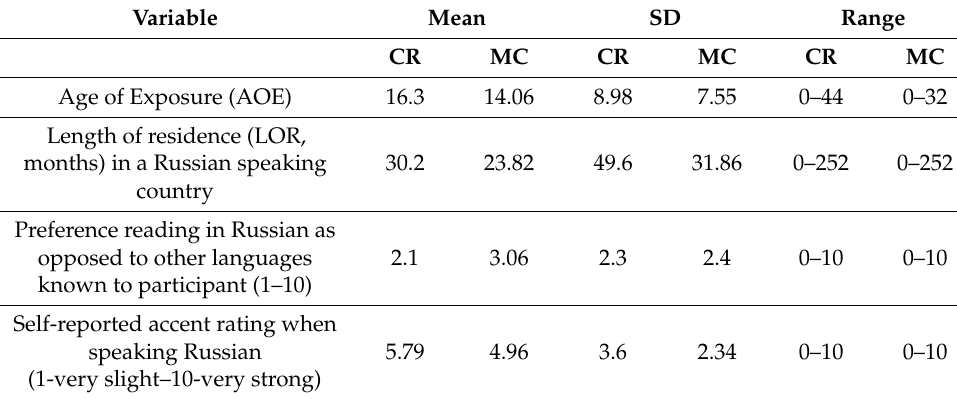
Table 4. Summary of participants’ language background information (based on self-reported mea- sures), for the CR and MC test